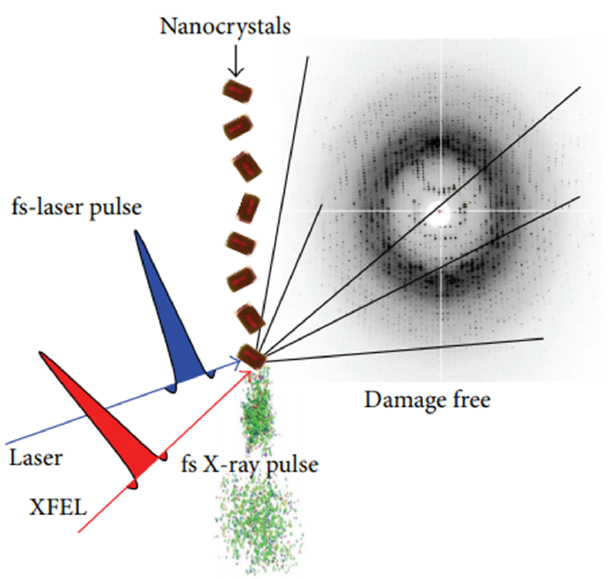
Figure 11. Principle of the TR serial femtosecond crystallography and the “diffraction-before-destruction” method. Figure reproduced with permission from Schmidt et al. [107]. Copyright (2013) Hindawi Publishing Corporation.